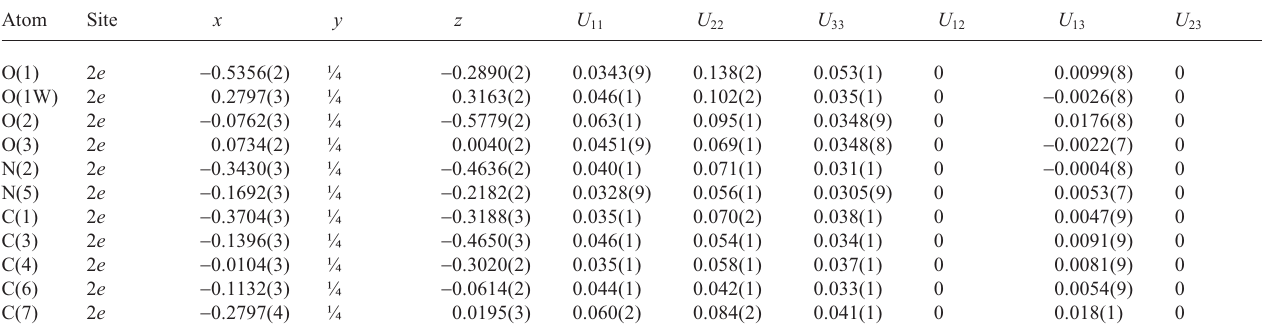
Table 3. Atomic coordinates and displacement parameters (in Å 2 )